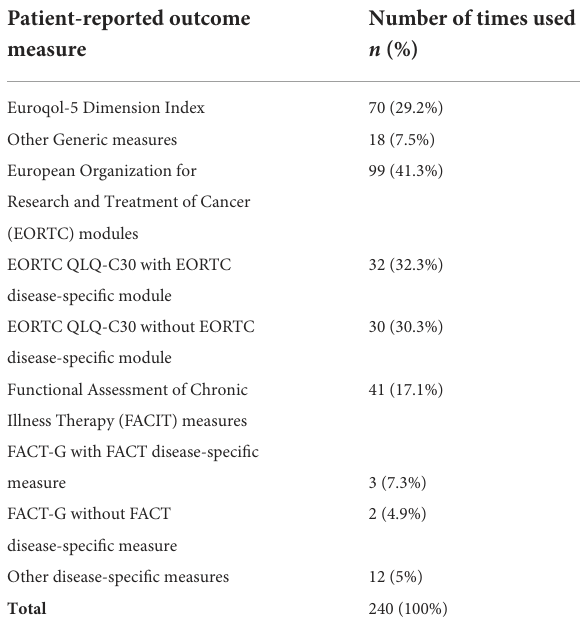
TABLE 3 Patient-reported outcome measures selected for the studies included in the